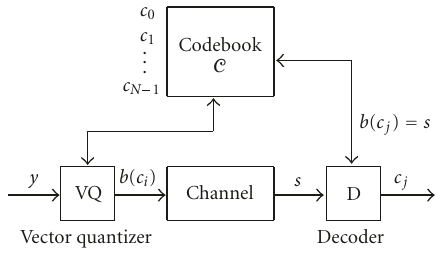
Figure 1: Signal transmission by vector